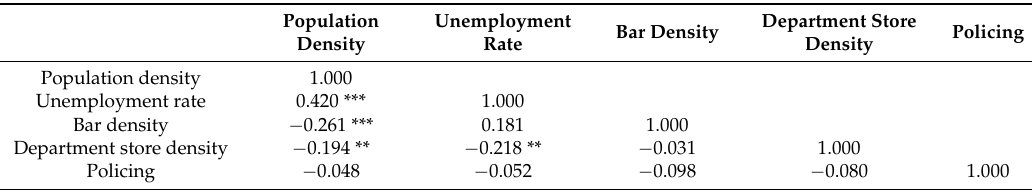
Table 1. Correlation matrix of the